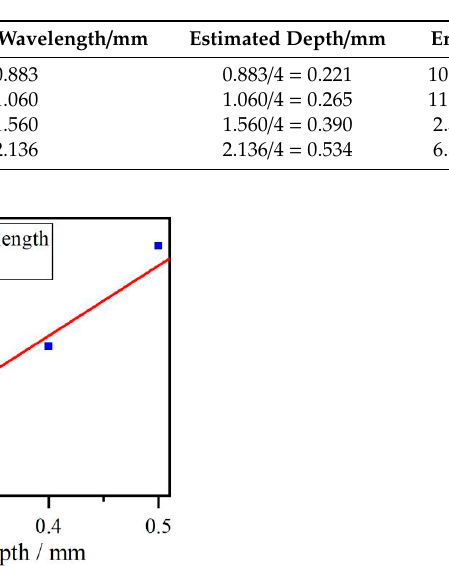
Figure 8. The energy distribution vs frequency spectrum. ( a ) Crack depth is 0.2 mm, ( b ) crack depth is 0.3 mm, ( c ) crack depth is 0.4 mm, and ( d ) crack depth is 0.5 mm. Table 2. Estimated crack depth and relative error.